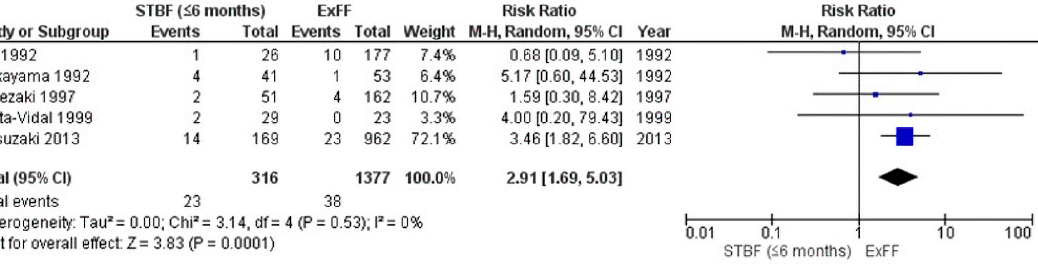
Figure 2. Forest plot of the risk ratios of HTLV-1 MTCT in the STBF ≤ 3 months group compared with that of the ExFF group. There is no statistical difference in the risk of MTCT between the two groups (pooled risk ratio (RR): 0.72, 95% CI: 0.30–1.77). Abbreviations: STBF, short-term breastfeeding; ExFF, exclusive formula feeding; M–H, Mantel–Haenszel; CI, confidence interval; RR, risk ratio; MTCT, mother-to-child transmission; events, number of cases with mother-to-child transmission; total, number of children born to carrier mothers; weight, influence of studies on overall meta-analysis. The figure is reproduced from Miyazawa et al. [103].